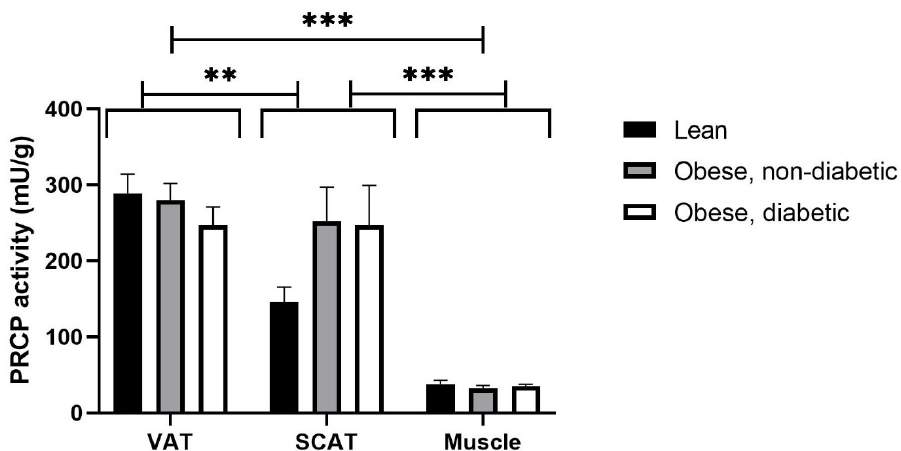
Figure 1. PRCP activity in VAT, SCAT and muscle tissue of lean subjects (black bars, n = 18 for VAT, n = 14 for SCAT and n = 16 for muscle tissue) and obese subjects without T2D (grey bars, n = 24 for VAT, n = 16 for SCAT and n = 12 for muscle tissue) and obese subjects with T2D (white bars, n = 11 for VAT, n = 7 for SCAT and n = 5 for muscle tissue). Results are presented as mean ± SEM. Significant differences are indicated on the graphs (** p < 0.01, *** p < 0.001).